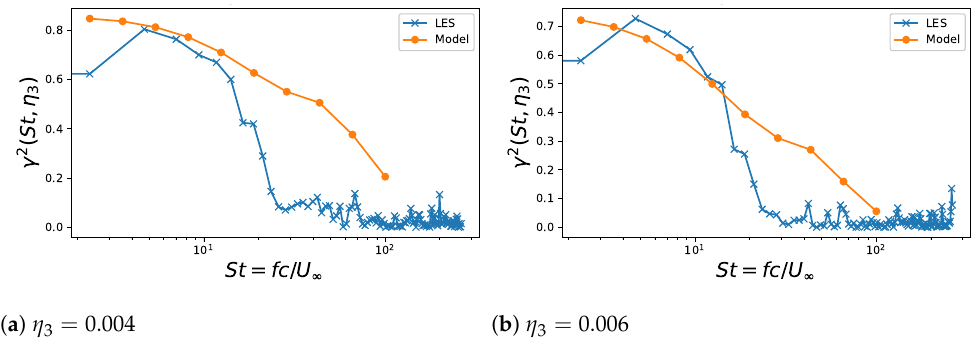
Figure 18. Examples of prediction of the transverse coherence function for various transverse separations ( η 3 ) by means of the analytical model based on Equations (8), (14) and